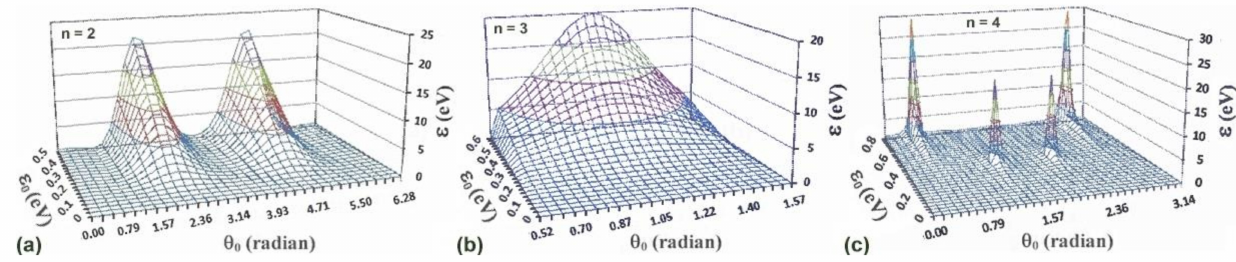
Figure 12. The dependencies of the steady state electron energy ε on the initial energy ε 0 and the phase angle θ 0 of the initial transverse velocity after acceleration by upper hybrid waves through ( a ) second harmonic, ( b ) third harmonic, and ( c ) fourth harmonic resonance